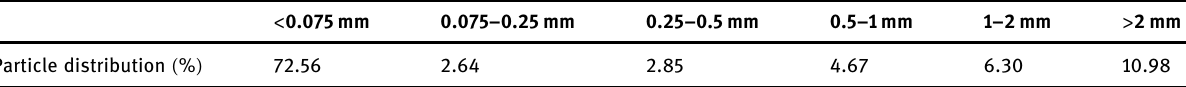
Table 1: Particle size distribution